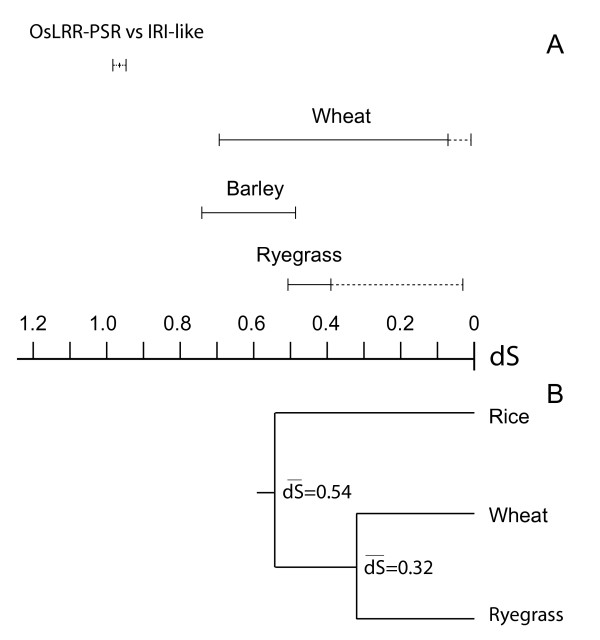
Synonymous divergence between paralogous and orthologous sequences. A) Maximum and minimum dS range between all IRI-like paralogous sequences of wheat, barley and perennial ryegrass and the average dS between OsLRR-PSR and all IRI-like sequences. Dotted lines for the divergence estimate between OsLRR-PSR and IRI-like sequences represent SD of the ortholog dS. Dotted lines for wheat and perennial ryegrass indicate changes in dS range if putative alleles are included. B) A tree indicating the average synonymous divergence, given in dS, estimated from ten control genes from rice, wheat, and perennial ryegrass.